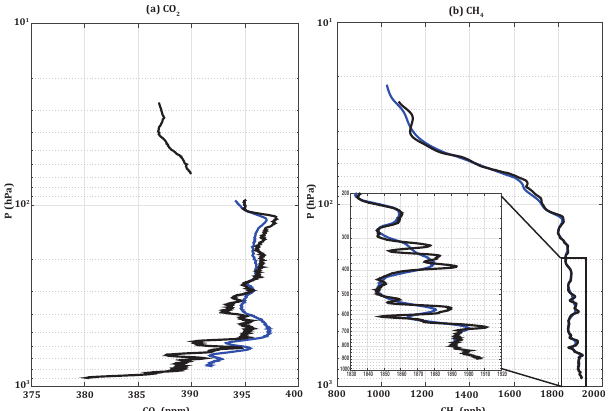
Figure 12. Vertical profiles retrieved from the air sampled with the AirCore-HR and an AirCore-GUF on the EdS-Stratéole flight on 29 August 2014. (a) CO 2 (ppm); (b) CH 4 (ppb). The dotted line in the CO 2 profiles corresponds to unrealistic CO 2 values sampled during the long plateau phase (see Sect.